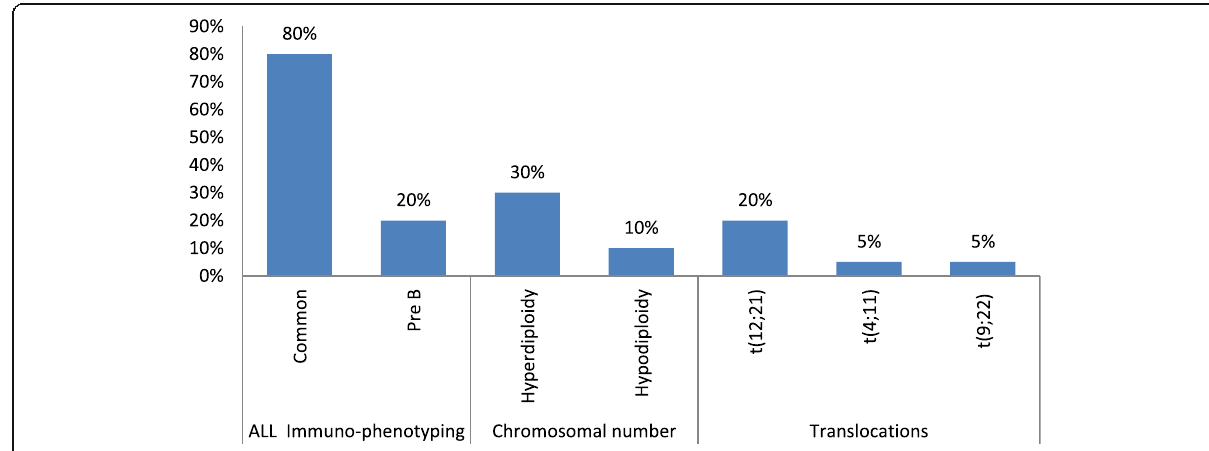
Fig. 1 Immunophenotypes and chromosomal abnormalities of acute lymphoblastic leukemia patients